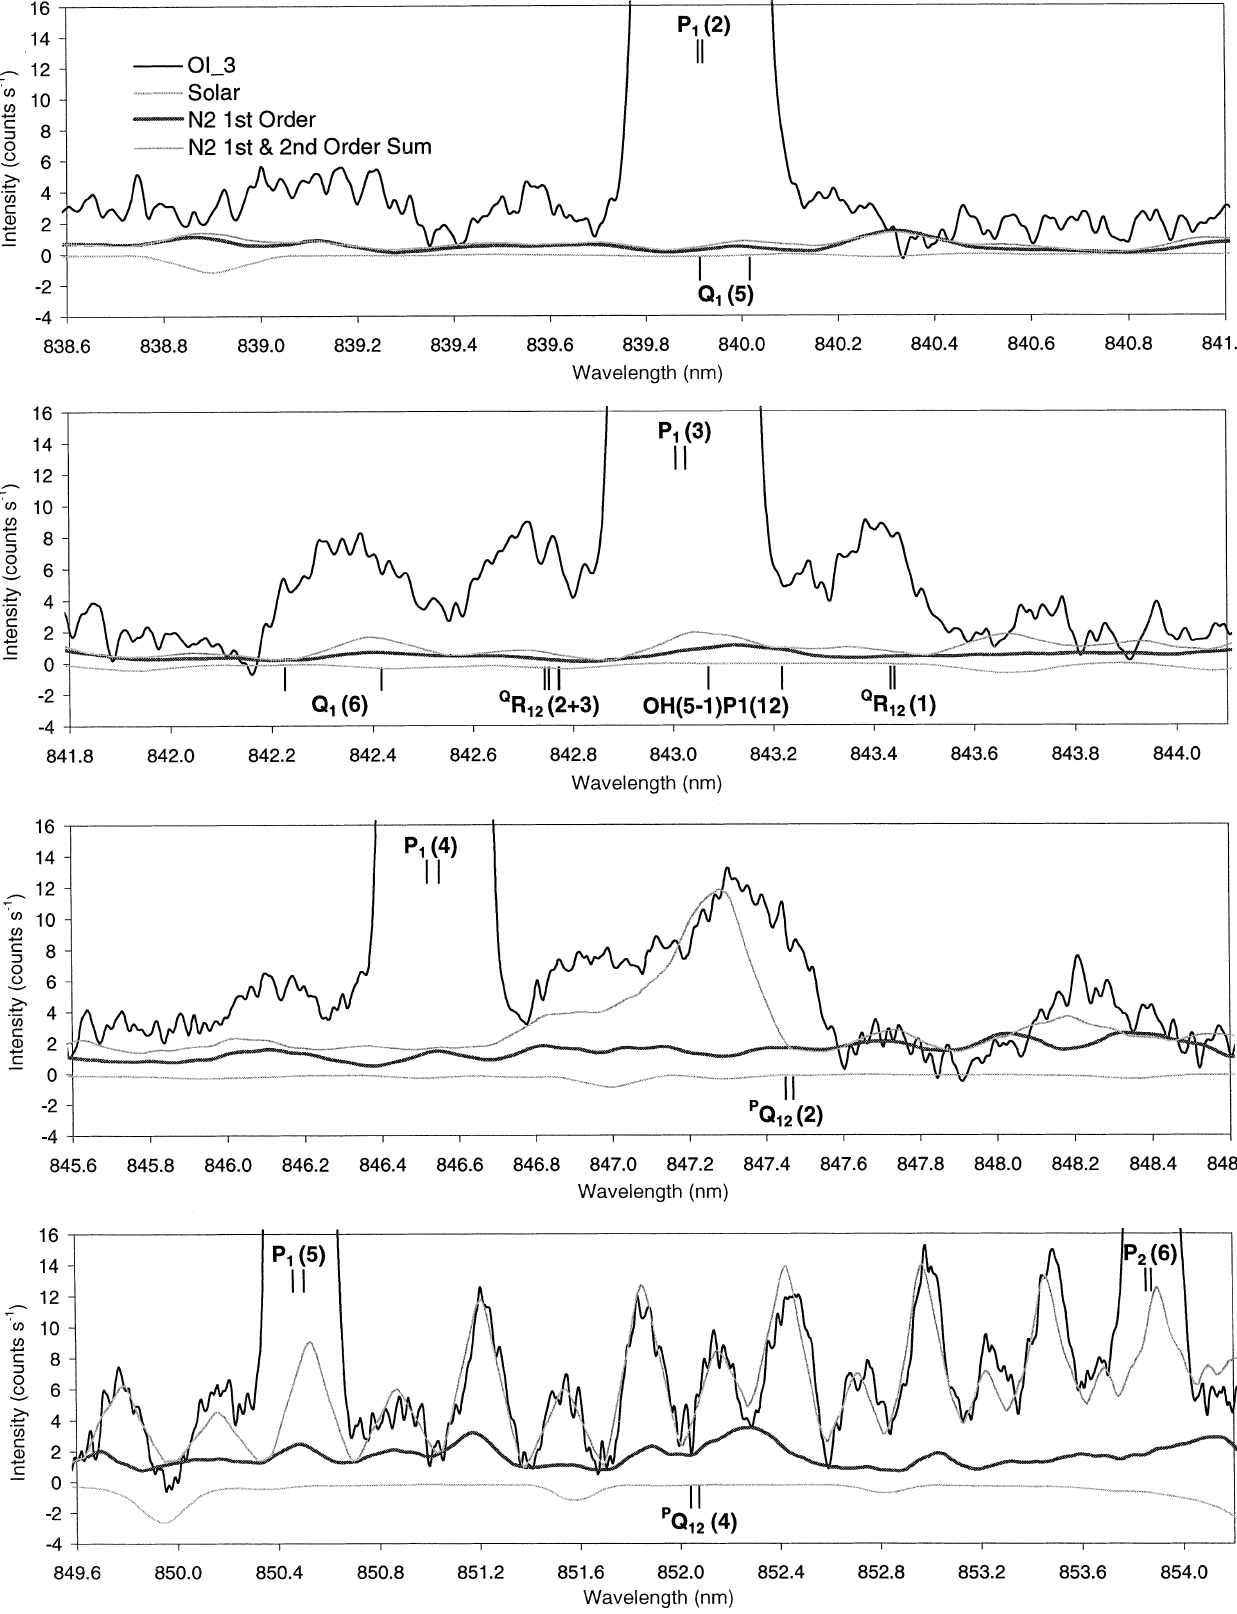
theoretical auroral contamination for first order only. A solar Fraunhofer spectrum, arbitrarily scaled to fit the data, is shown below the zero line. This contamination is from